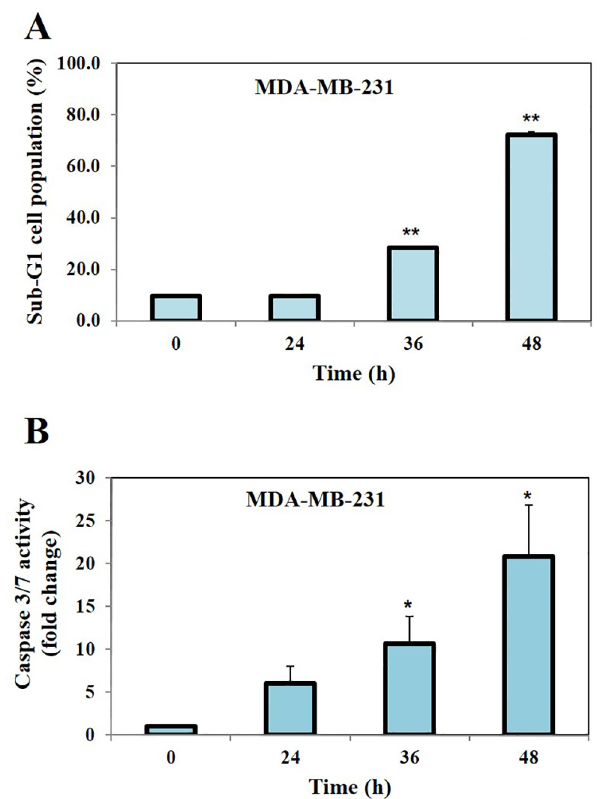
Fig 2. A, The analysis of cell cycle distribution following treatment with CIP was performed using flow cytometry. MDA-MB-231 cells were exposed to compound CIP (50 μ M) for indicated time intervals (0, 24, 36 and 48 h), after which the cells were harvested and stained with PI. The cell distribution across the various phases of the cell cycle was analyzed with a flow cytometer. We observed that CIP induced significant apoptosis in a time dependent manner as evidenced by increased accumulation of cells in Sub-G1 phase of the cell cycle. B, MDA-MB-231 cells were exposed to compound CIP (50 μ M) at indicated time intervals (0, 24, 36 and 48 h), after which they were harvested and caspase3/7 activity was measured using Caspase- Glo 1 3/7 assay kit. We found that treatment of MDA-MB-231 cells with CIP caused the significant increase in the caspases-3/7 activity. * for p < 0.05, ** for p <